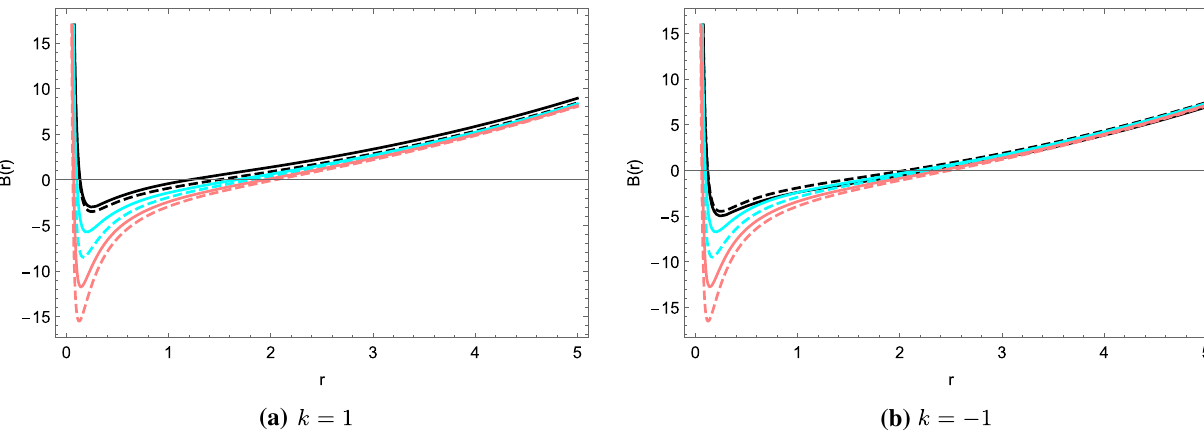
Fig. 1 Metric functions B 0 ( r ) with k = ± 1. The black curve, black dashed curve, cyan curve, cyan dashed curve, pink curve and pink dashed curve correspond to metric functions B 0 ( r ) with c 2 = − 1 , − 2 , − 3 , − 4 , − 5 , − 6 respectively. Other parameters are set as q = 0 . 4 and (cid:3) = − 0 . 1